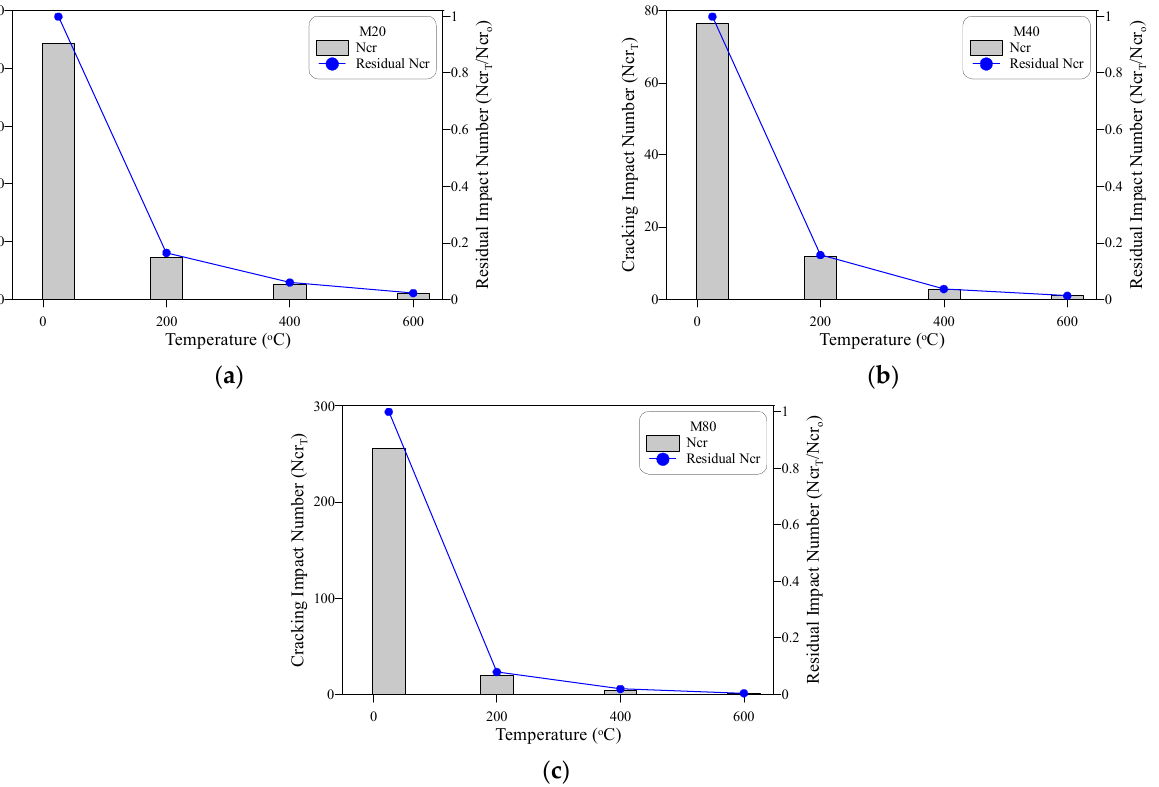
Figure 11. Cracking impact number at different temperatures: ( a ) M20, ( b ) M40, ( c ) M80.